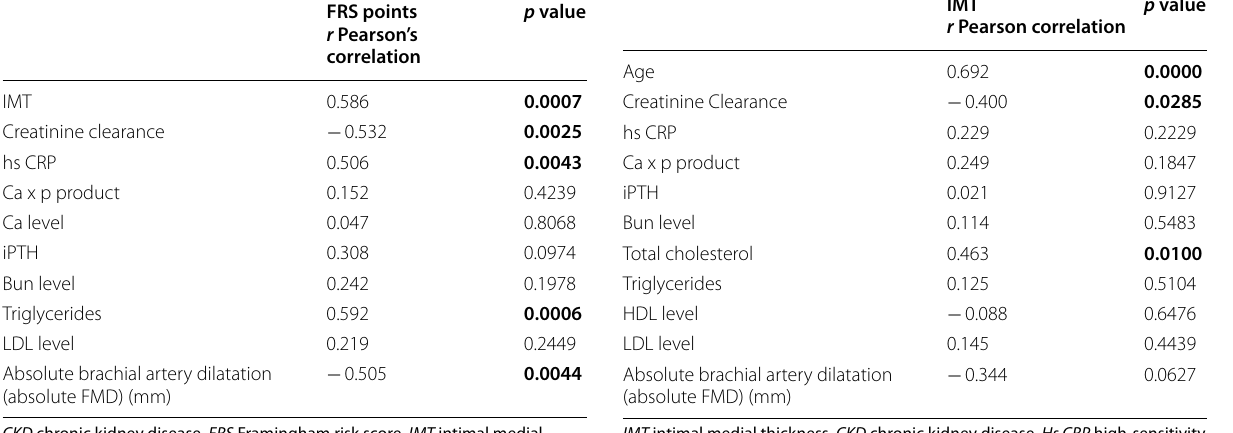
Table 4 Correlation between IMT, age, inflammation and laboratory data in